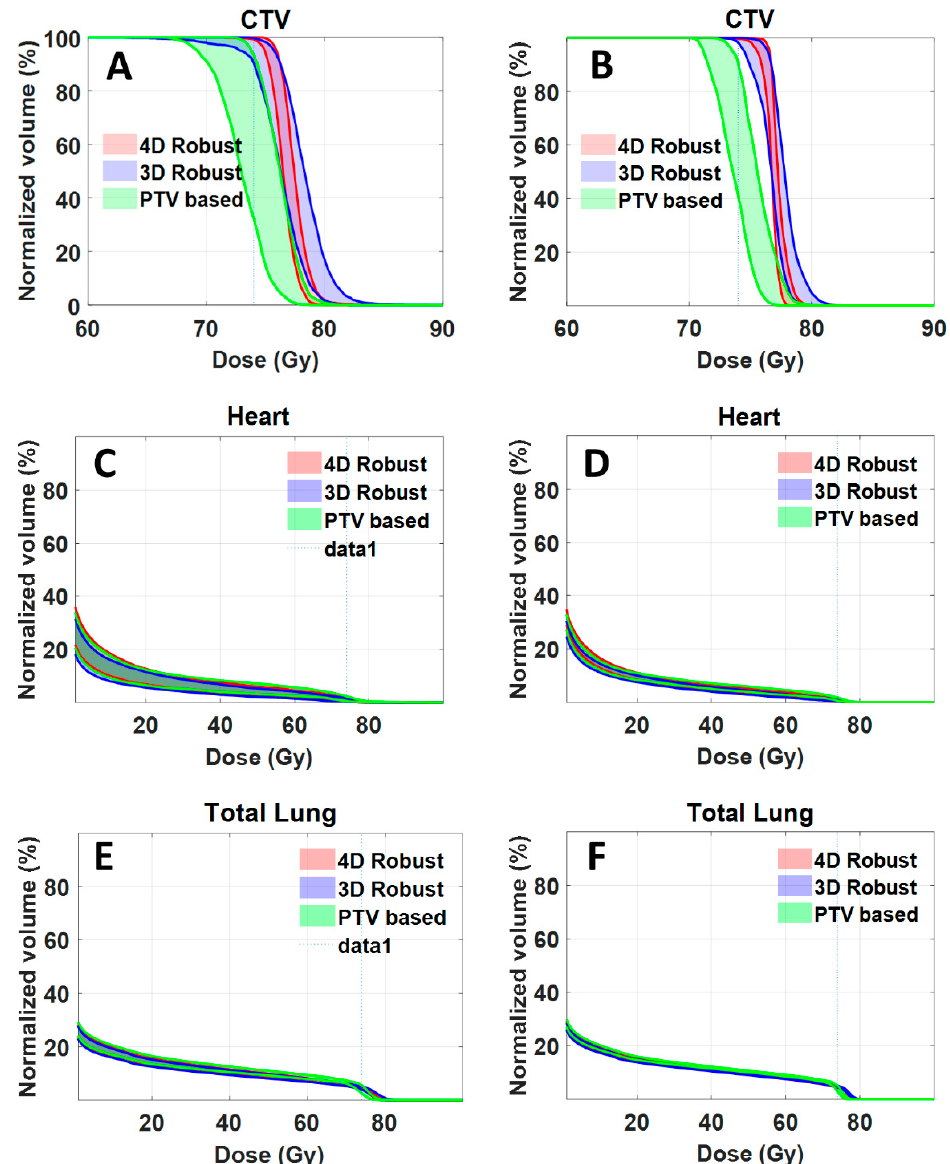
Figure 4. DVHs of CTV, heart and total lung for plans produced by three optimization methods for patient J. Panel ( A , C , E ) shows the DVH bands of 90 dose distributions of nine setup and range uncertainty scenarios for each of the 10 respiratory phases for CTV, heart and total lung respectively. Panel ( B , D , F ) shows the DVH bands of dose distributions accumulated over all the respiratory phases for each of the 9 setup and range uncertainty scenarios for CTV, heart and total lung respectively.